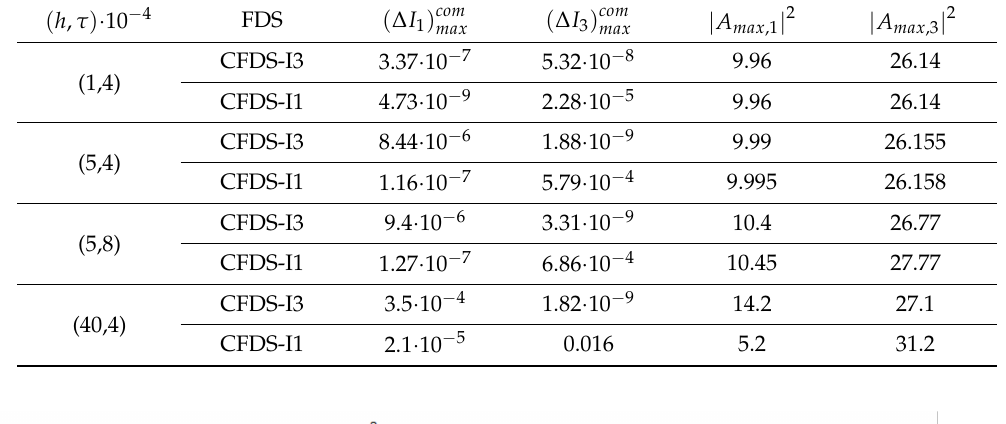
Table 2. Dependence of the invariant deviations and maximal intensities | A max ,1 | 2 , | A max ,3 | 2 at the pulse centers on mesh steps. Iteration maximal number does not exceed N iter = 4.